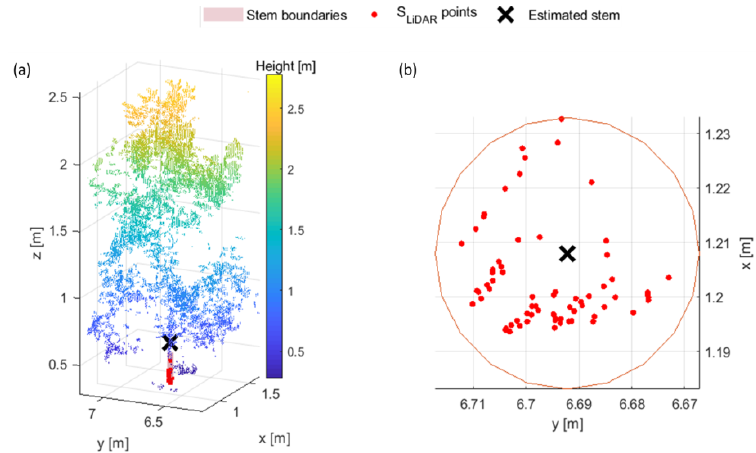
Figure 8. ( a ) Stem point selection marked in red between 0.1 m and 0.3 m and ( b ) selected stem points